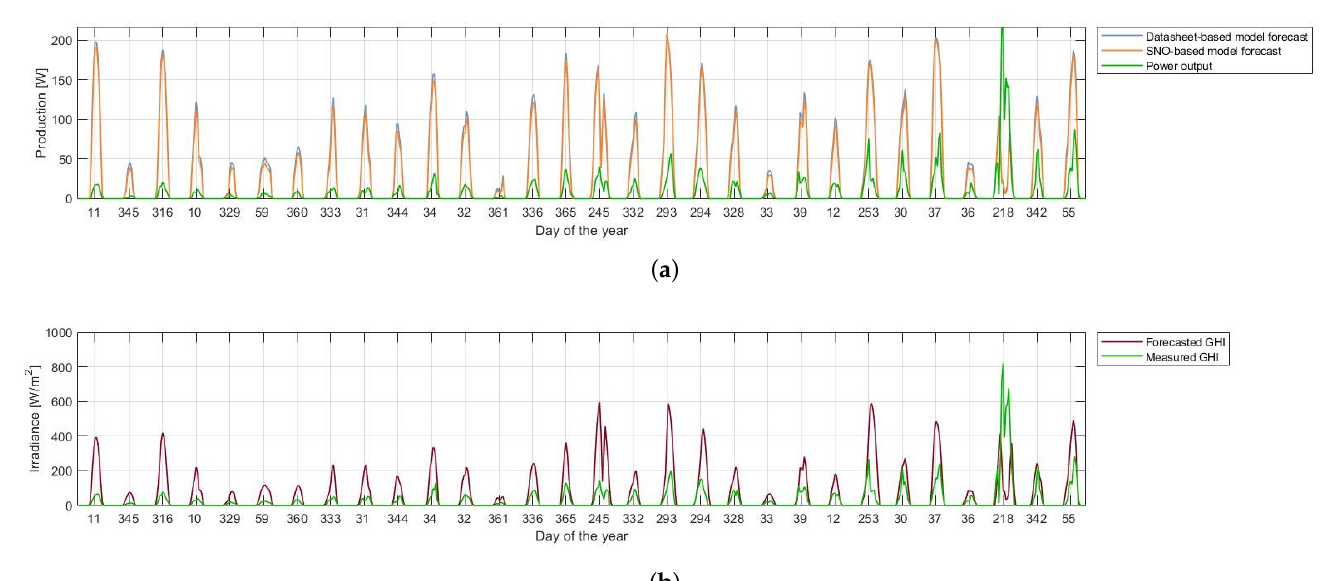
Figure 8. Comparison on the 30 worst days of the datasheet-based model with respect to ( a ) the forecasted power of the two physical models and ( b ) the forecasted and measured